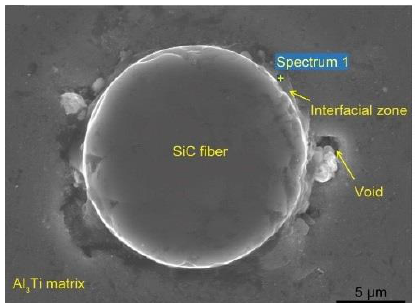
Figure 21. SEM micrograph of the interfacial zone between the SiC fiber and the Al 3 Ti intermetallic compound matrix in the Ti-(SiC f /Al 3 Ti)-laminated composite.